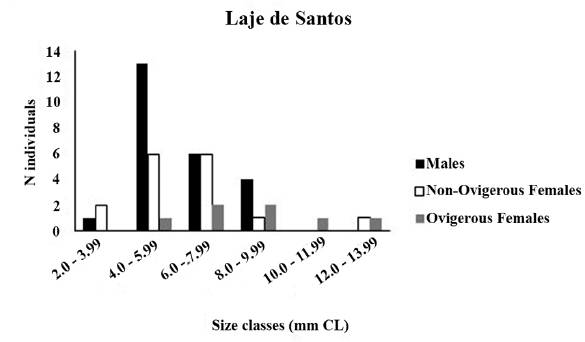
Figure 5. Size-class distribution of Alpheus formosus collected at Laje de Santos, São Paulo State, Brazil.